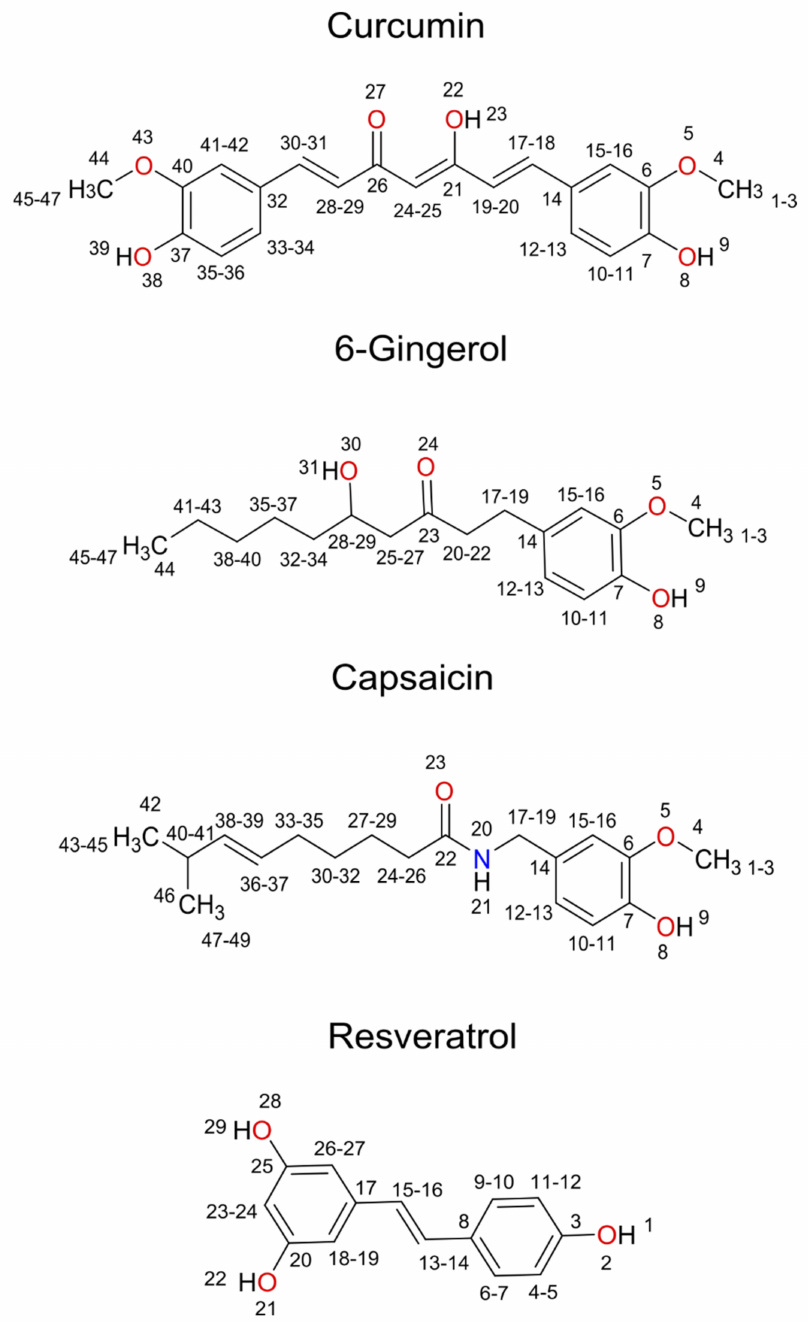
Figure 1. Structural formulas of curcumin, 6-gingerol, capsaicin, and resveratrol with atom